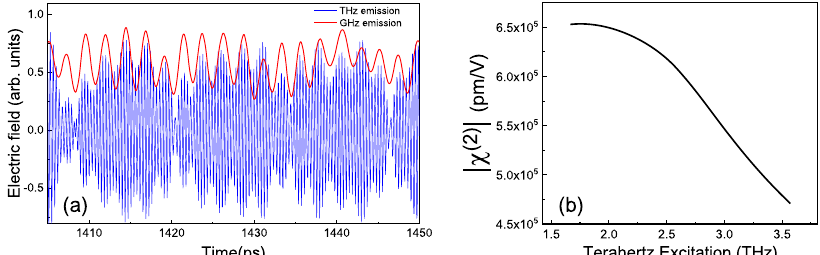
Fig. 7 Phase matching and nonlinear susceptibility between mmWave and THz emission. a Electric fi eld as a function of time for both mmWave (red curve, fi ltered response of THz spectrum) and THz emission (blue) over a short time window illustrating the phase matched process between the two emission bands, b Modulus of second-order nonlinear susceptibility χ (2) as a function of THz excitation energy, calculated from the QCL bandstructure, showing the exalted giant